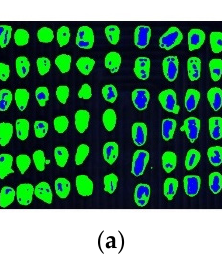
(spectral features). ( a ) SVM and ( b ) LDA.